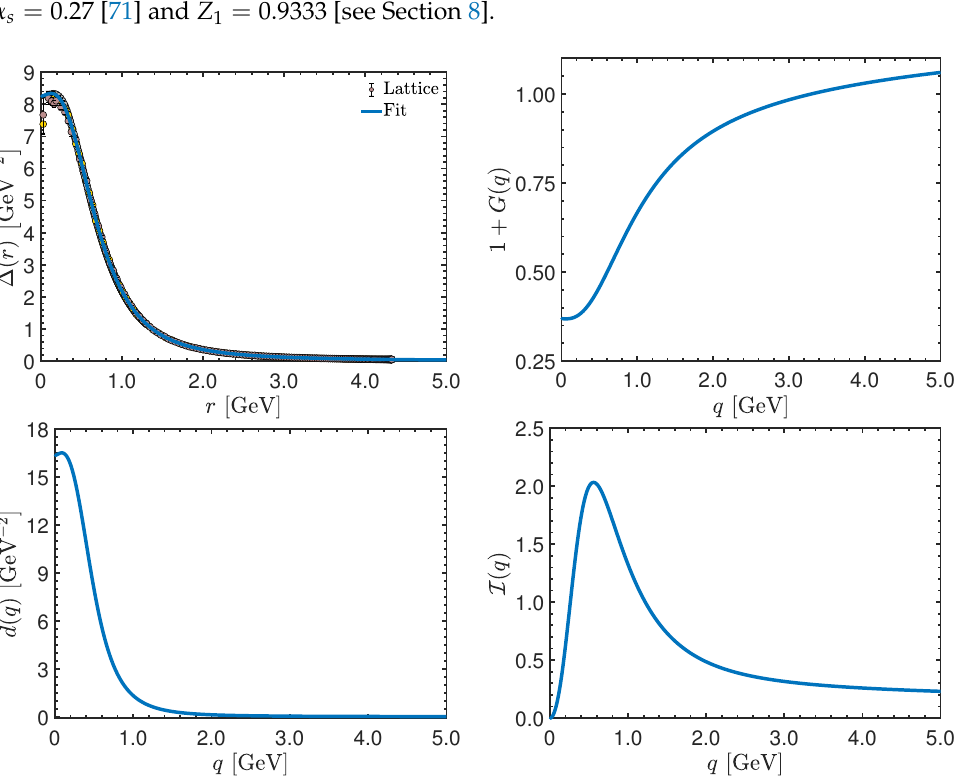
Figure 9. Top left : Gluon propagator, ∆ ( q ) , from lattice simulations of Reference [85] (points) and a fit given by Equation (C11) of [124] (blue continuous). Top right : The auxiliary function 1 + G ( q ) , defined in Equation (12). Bottom left : The renormalization group invariant (RGI) running interaction d ( q ) defined in Equation (69), computed using the ∆ ( q ) and 1 + G ( q ) shown in the top strength panels, with α s = 0.27 [71] and Z 1 = 0.9333 [see Section 8]. Bottom right : The corresponding (cid:98) ( q ) , defined in Equation dimensionless RGI interaction I